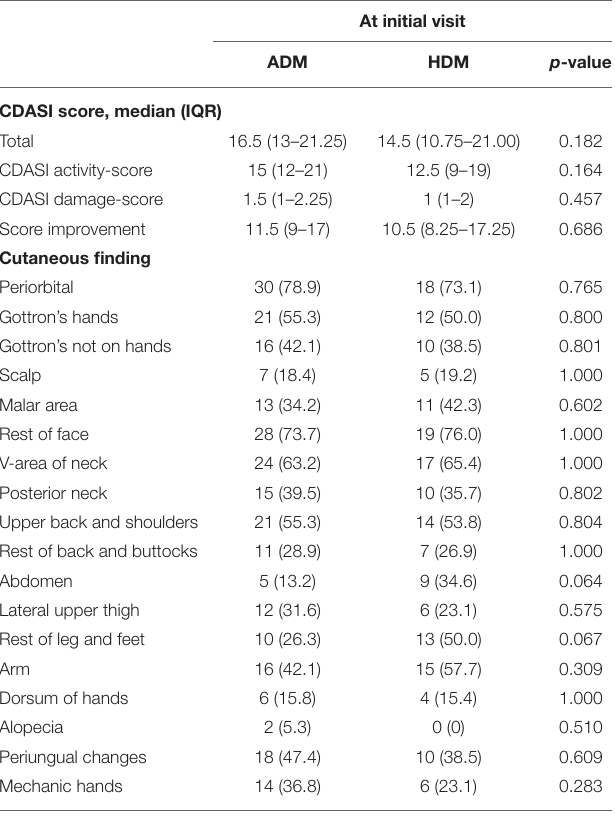
TABLE 2 | Cutaneous findings of patients with dermatomyositis at baseline visit as measured by CDASI activity and damage.